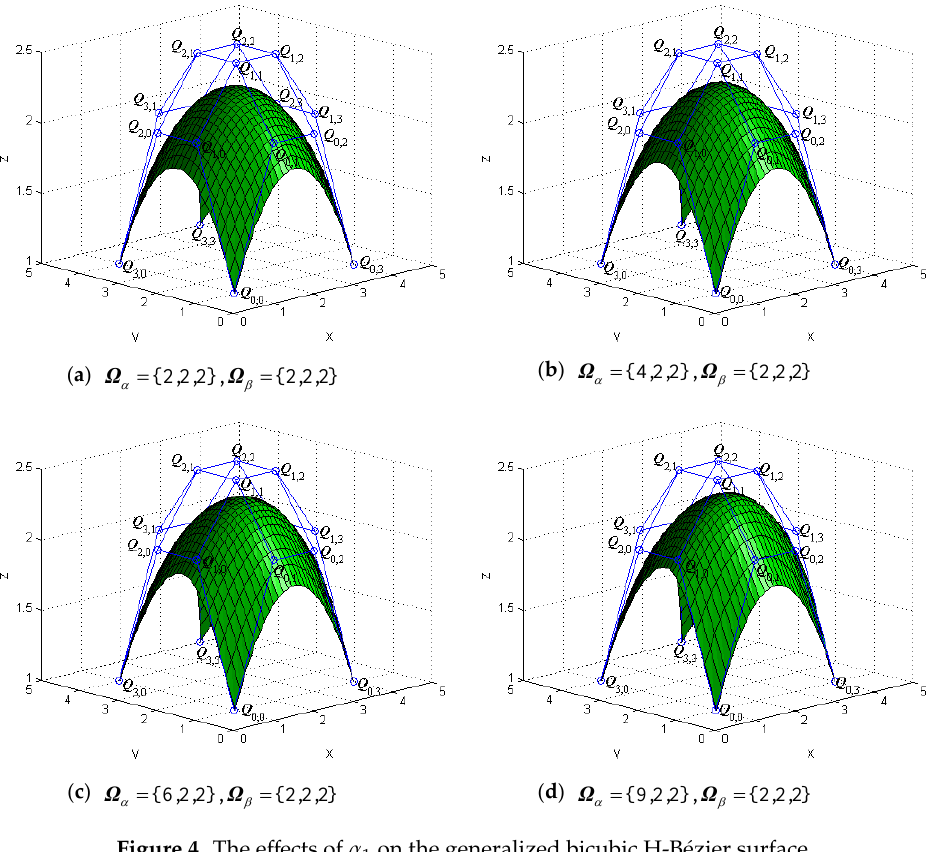
Figure 4. The effects of α 1 on the generalized bicubic H-B é zier surface.